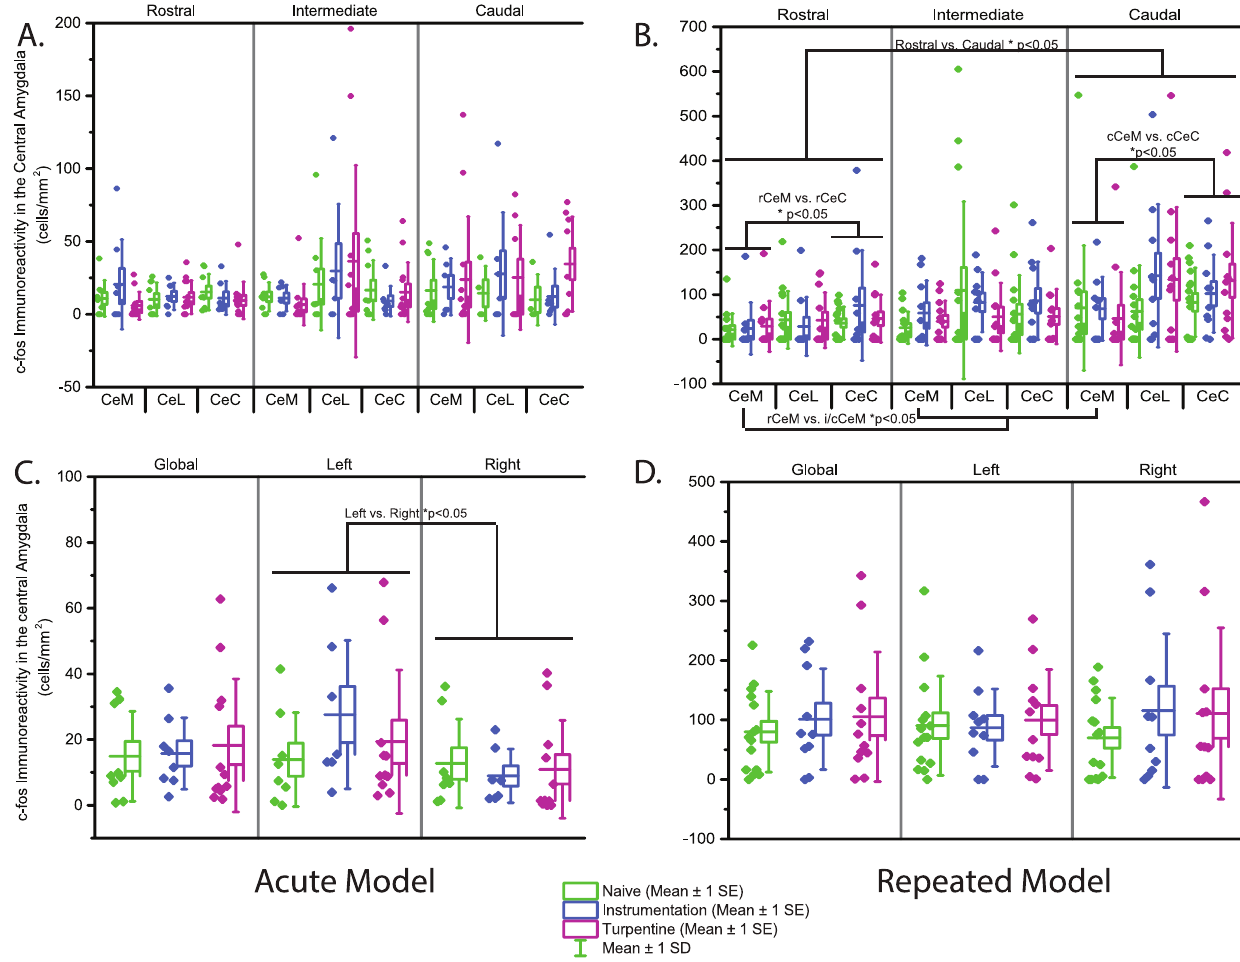
Figure 4. c-Fos immunoreactivity in the central amygdala in response to open field exposure 24hrs after acute ( A , C ; n=8–13) or repeated ( D , F ; n=7–15) bladder inflammation. A / D - Global CeA (central amygdala) c-Fos immunoreactivity, B / E - right CeA, C / F - left CeA.